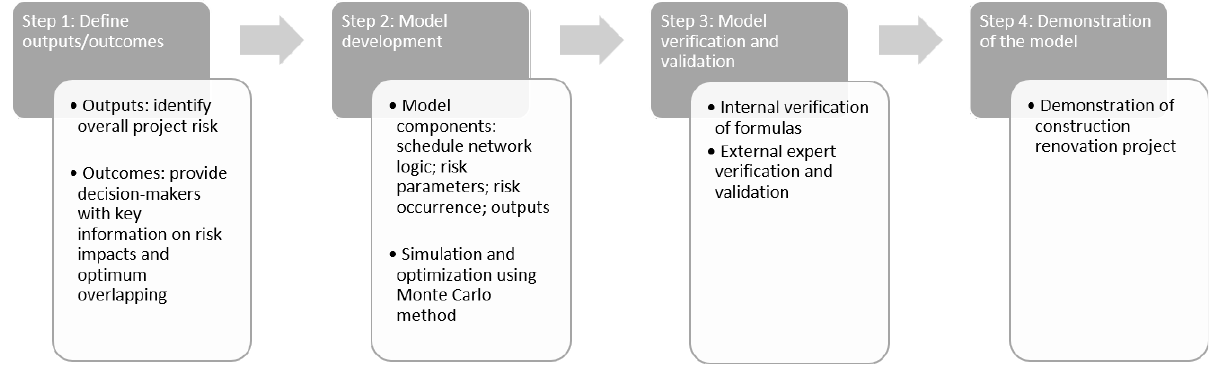
Figure 1. The methodology framework.